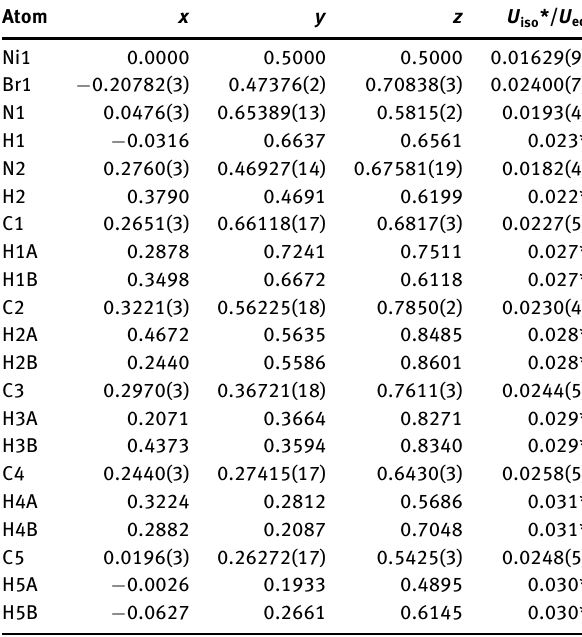
Table 2: Fractional atomic coordinates and isotropic or equivalent isotropic displacement parameters (Å 2